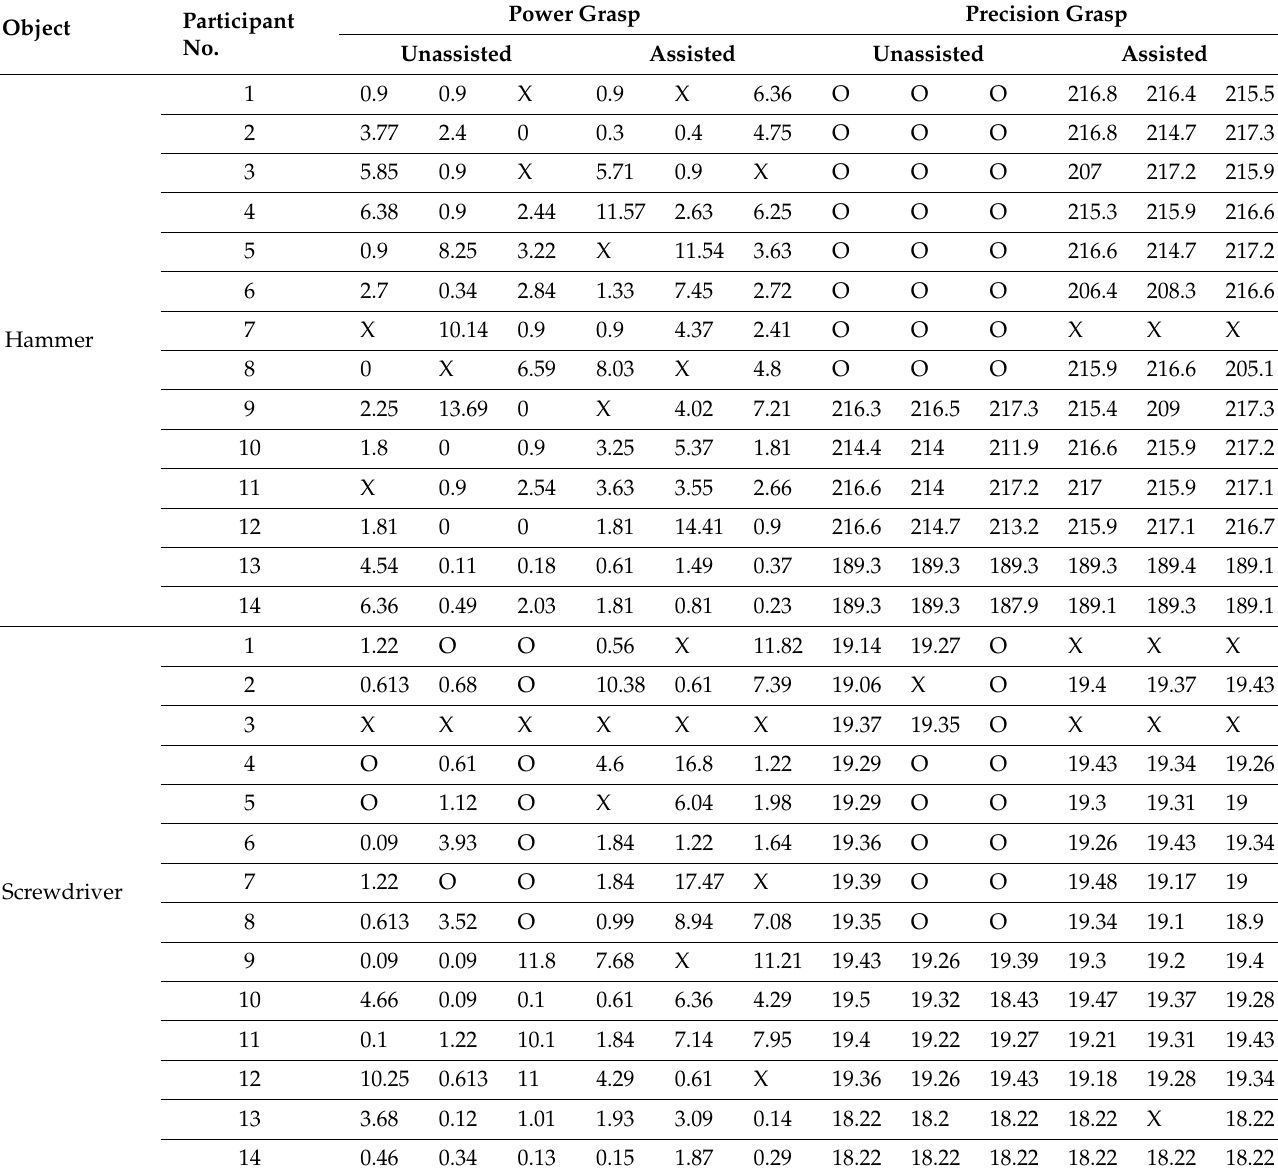
Table A1. Experimental quality measure